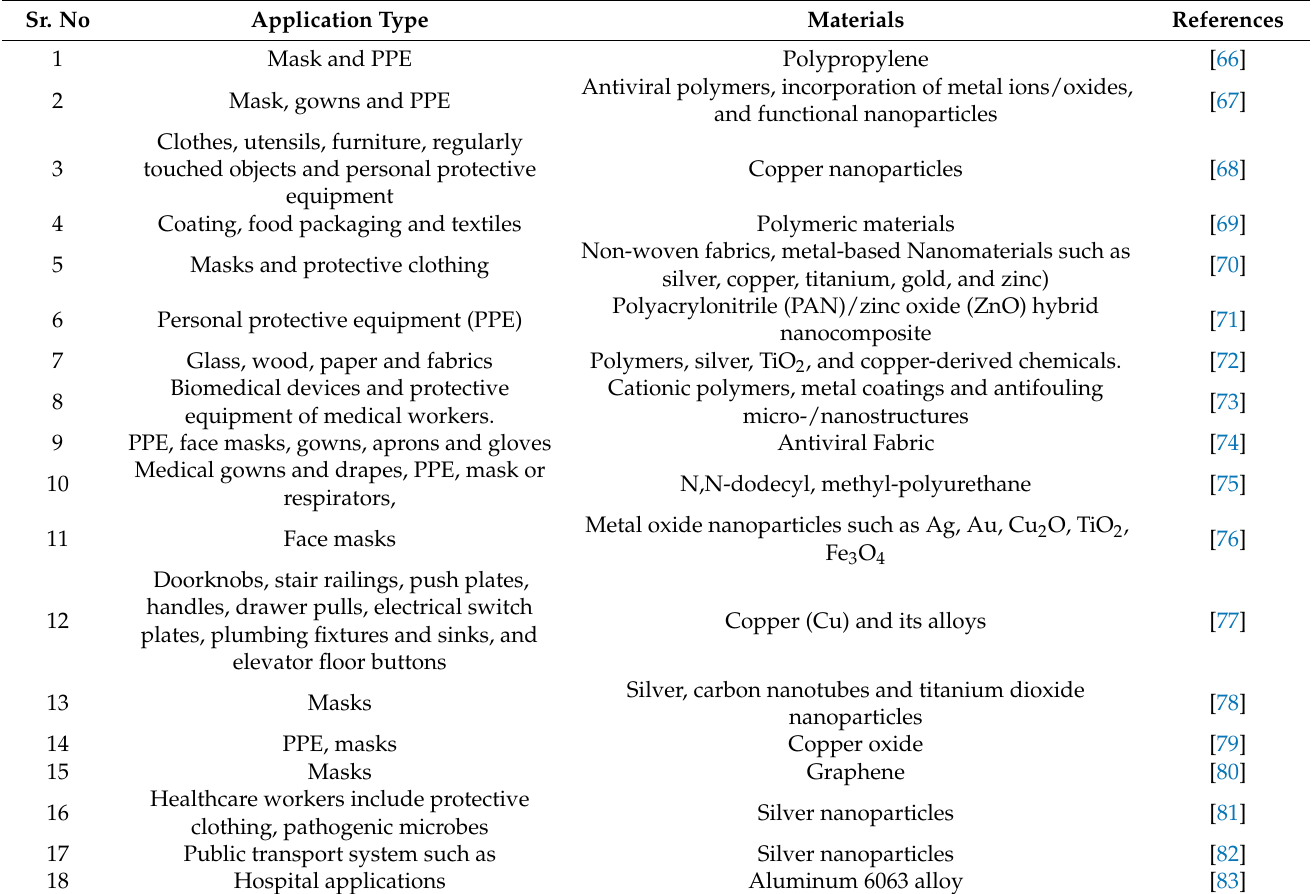
Table 3. Examples of sterilizing surface coatings against the spread of communicable